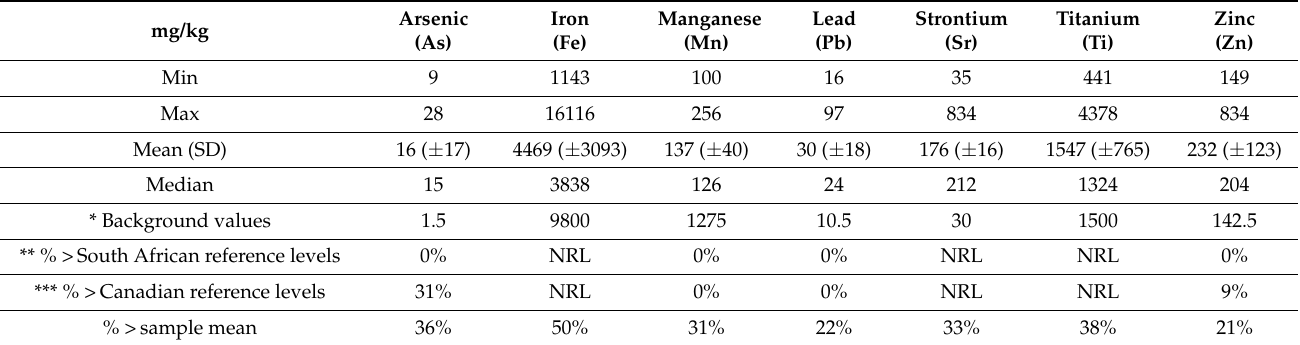
Table 2. Summary of heavy metal levels in soil ( n =